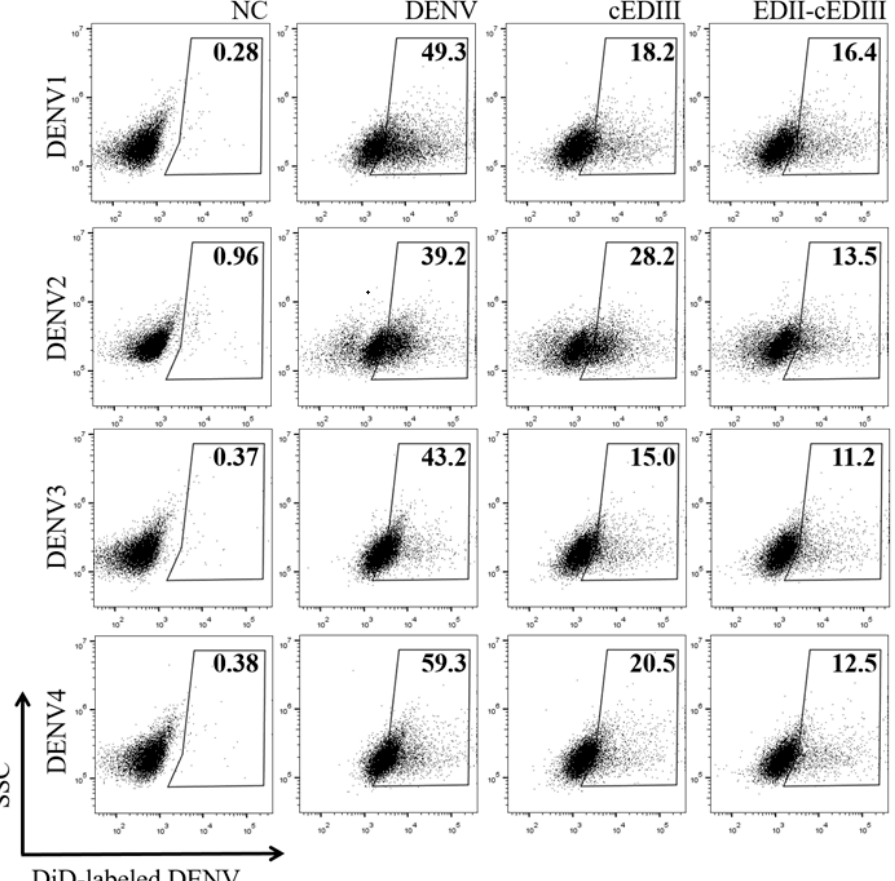
Figure 2. Neutralization of DENV infection in U937-DC-SIGN cells by Ab in vitro. Neutralizing activity was assessed by evaluating the effects on DENV infection in U937-DC-SIGN cells. X - and y -axes represent side scatter (SSC) and the level of DiD-labeled DENV, respectively. Percentage of DENV-positive cells is shown in the gating box. NC (negative control; no infection), DENV (only DENV infection), cEDIII (DENV and anti-cEDIII Ab), EDII-cEDIII (DENV and anti-EDII-cEDIII Ab). A representative result of three independent experiments is shown.